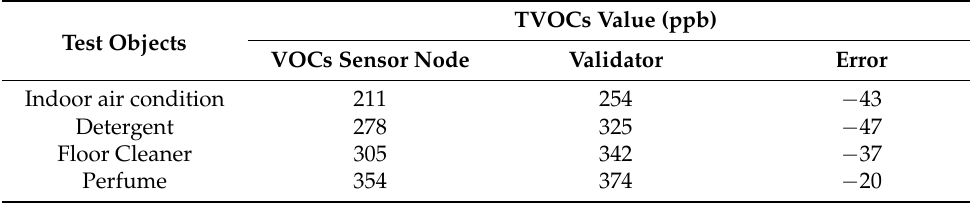
Table 4. Validation results.